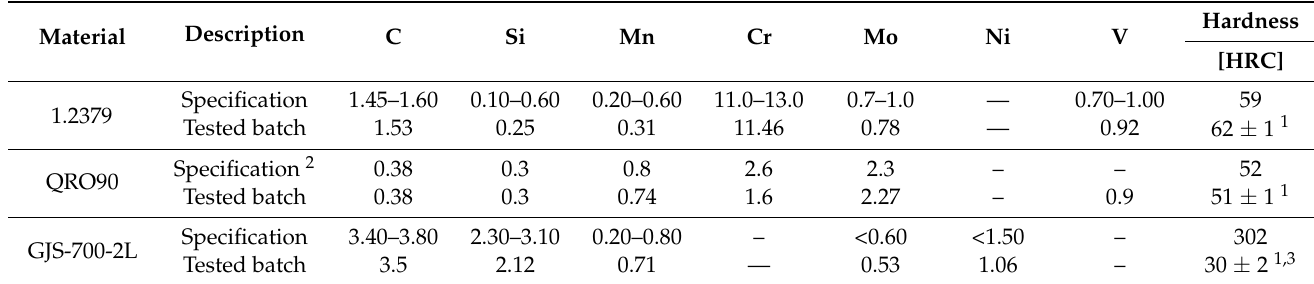
Table 3. Chemical composition (wt%) and hardness (HRC) measured on the tool material samples.